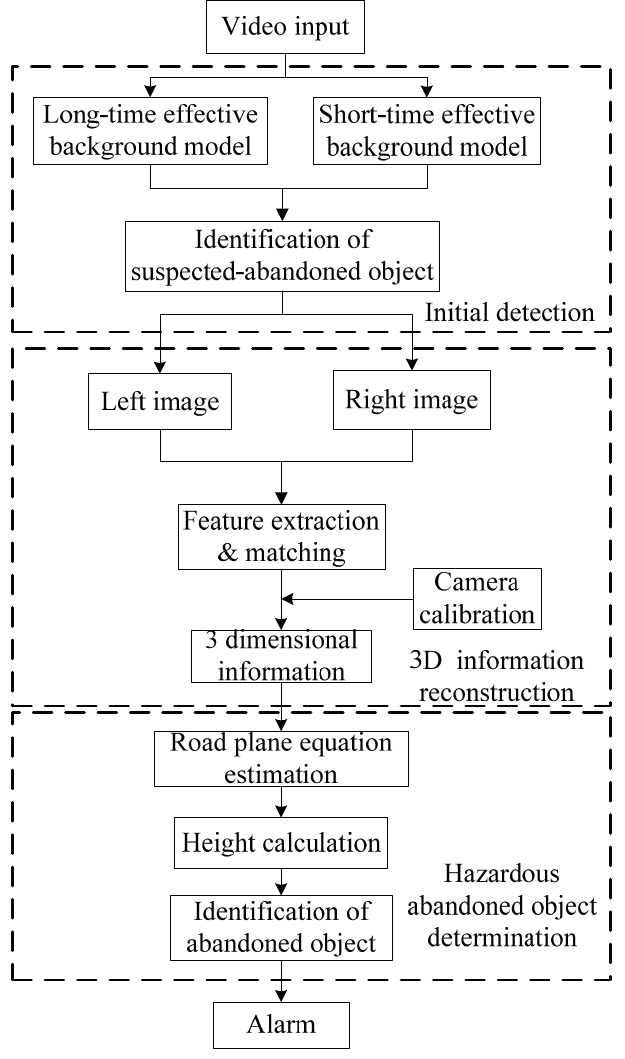
Figure 4. Block diagram of the abandoned object recognition